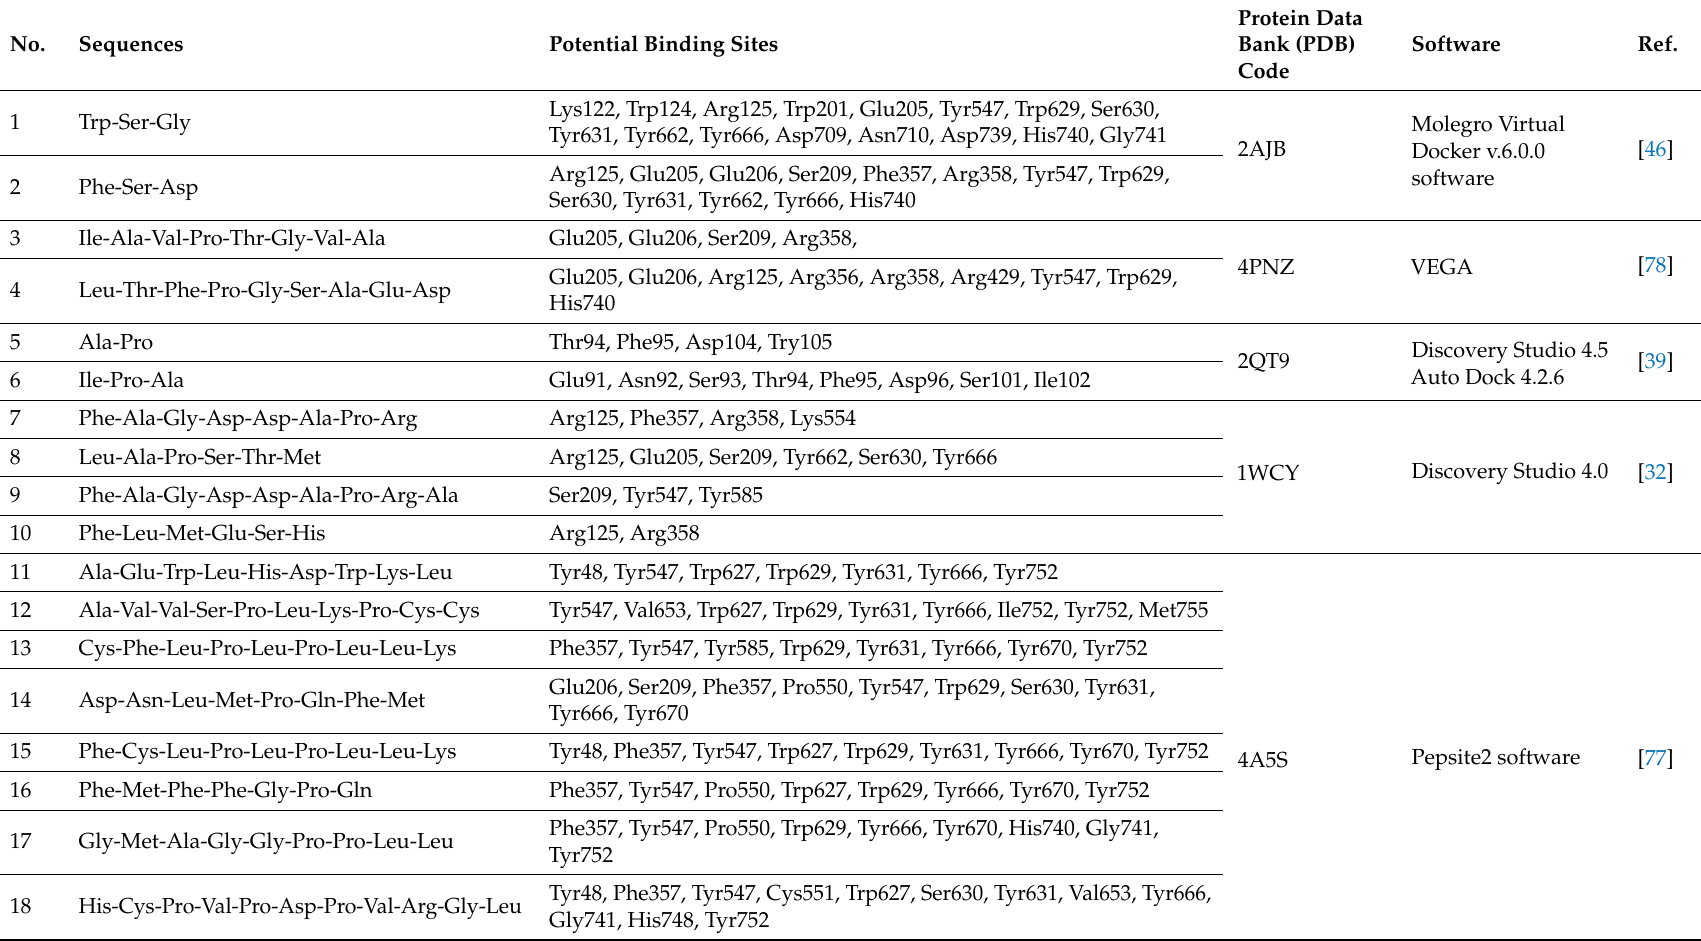
Table 2. Recently reported potential binding sites of DPP-IV inhibitory peptides based on molecular docking